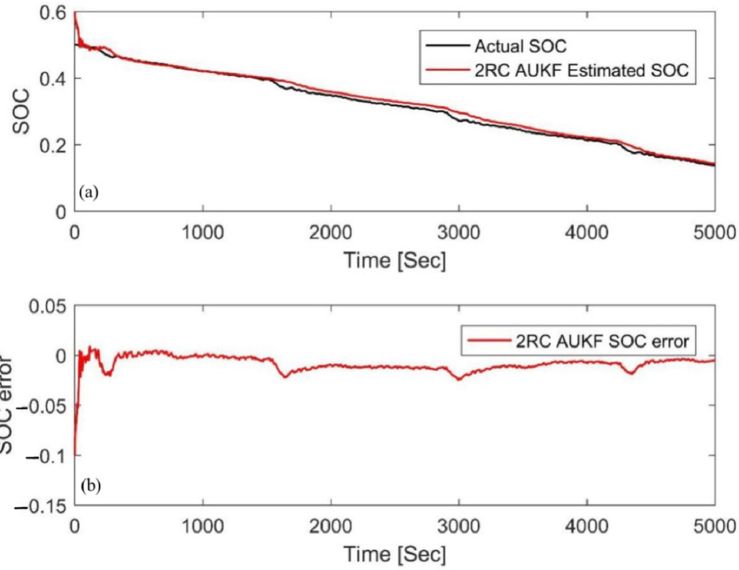
Figure 13. Estimation results at an initial SOC of 60% via the FUDS at 45 °C. ( a ) SOC estimation comparison curve; ( b ) SOC estimation error.